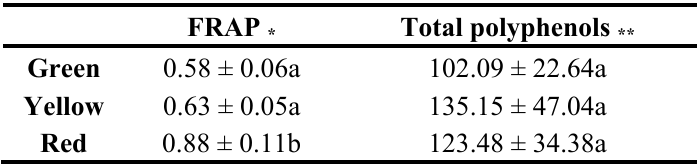
Table 3. Total antioxidant capacity measured by FRAP and total phenol content of Solanum indicum L. at different maturation stages.